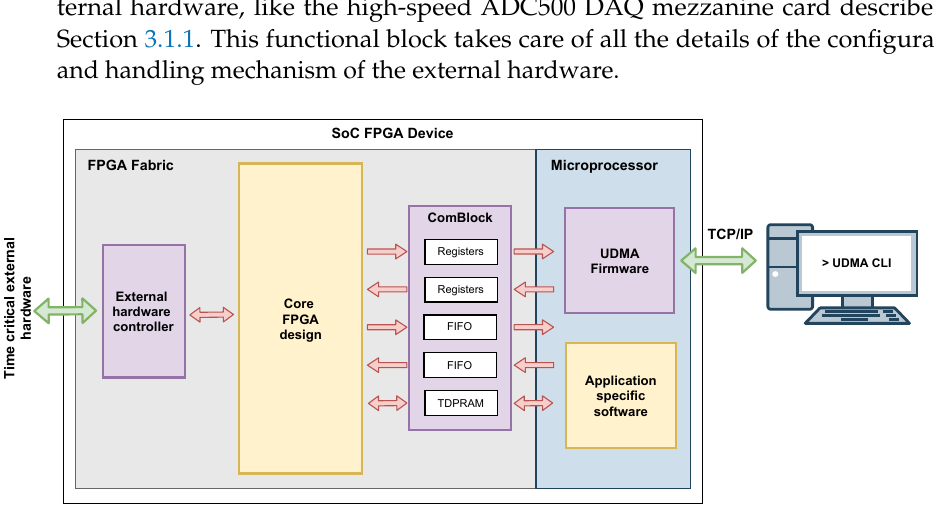
Figure 5. Block diagram with the main components of the SoC-FPGA of the experimental hardware platform. The purple boxes are the provided common services, and the yellow boxes are the user’s free design and programming